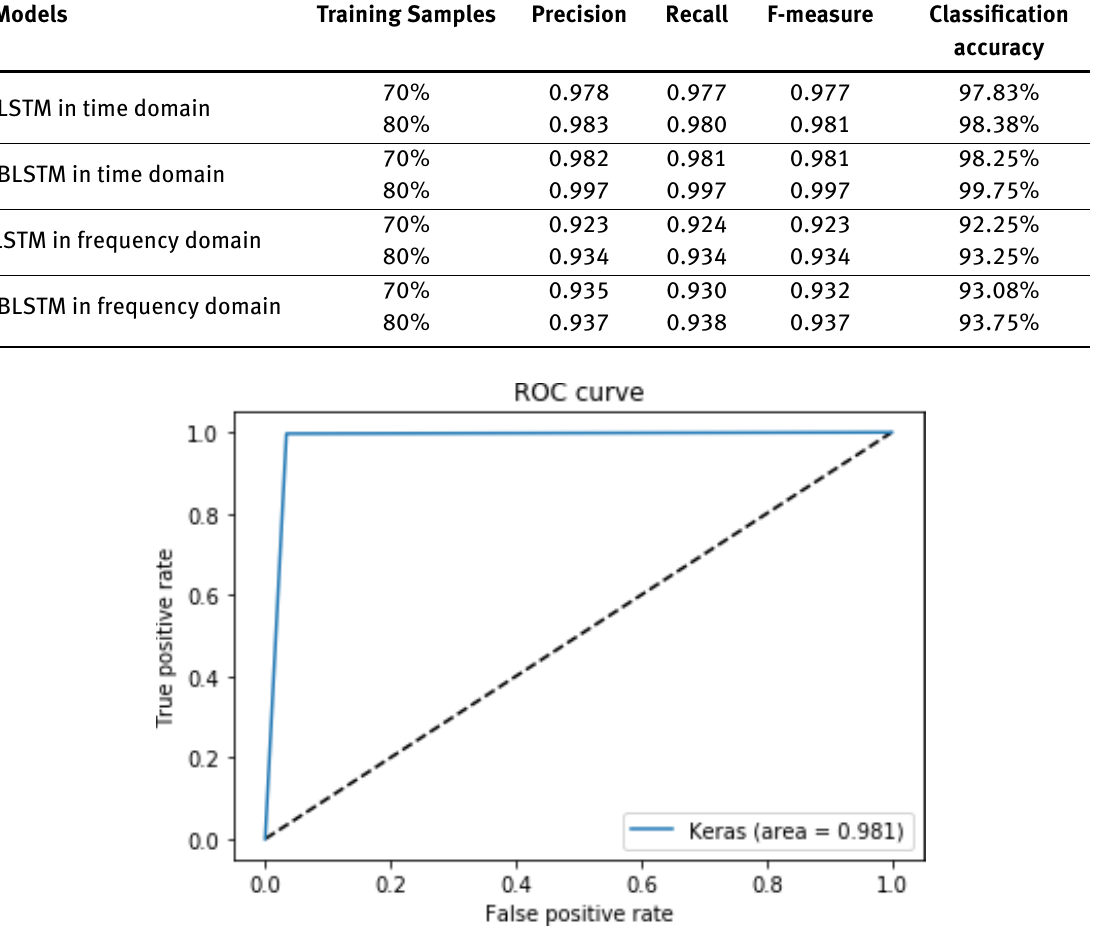
Figure 8: ROC curve for 70% training using LSTM in time